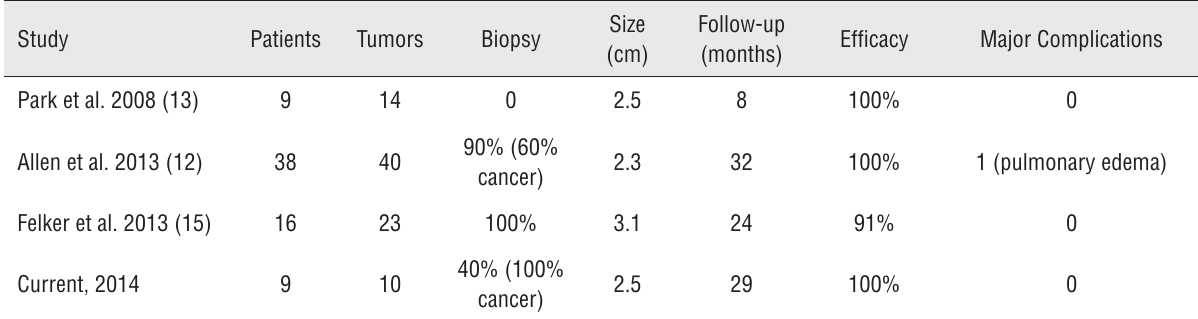
Table 3 - RfA of cystic renal lesions to date. Study Patients Tumors Biopsy